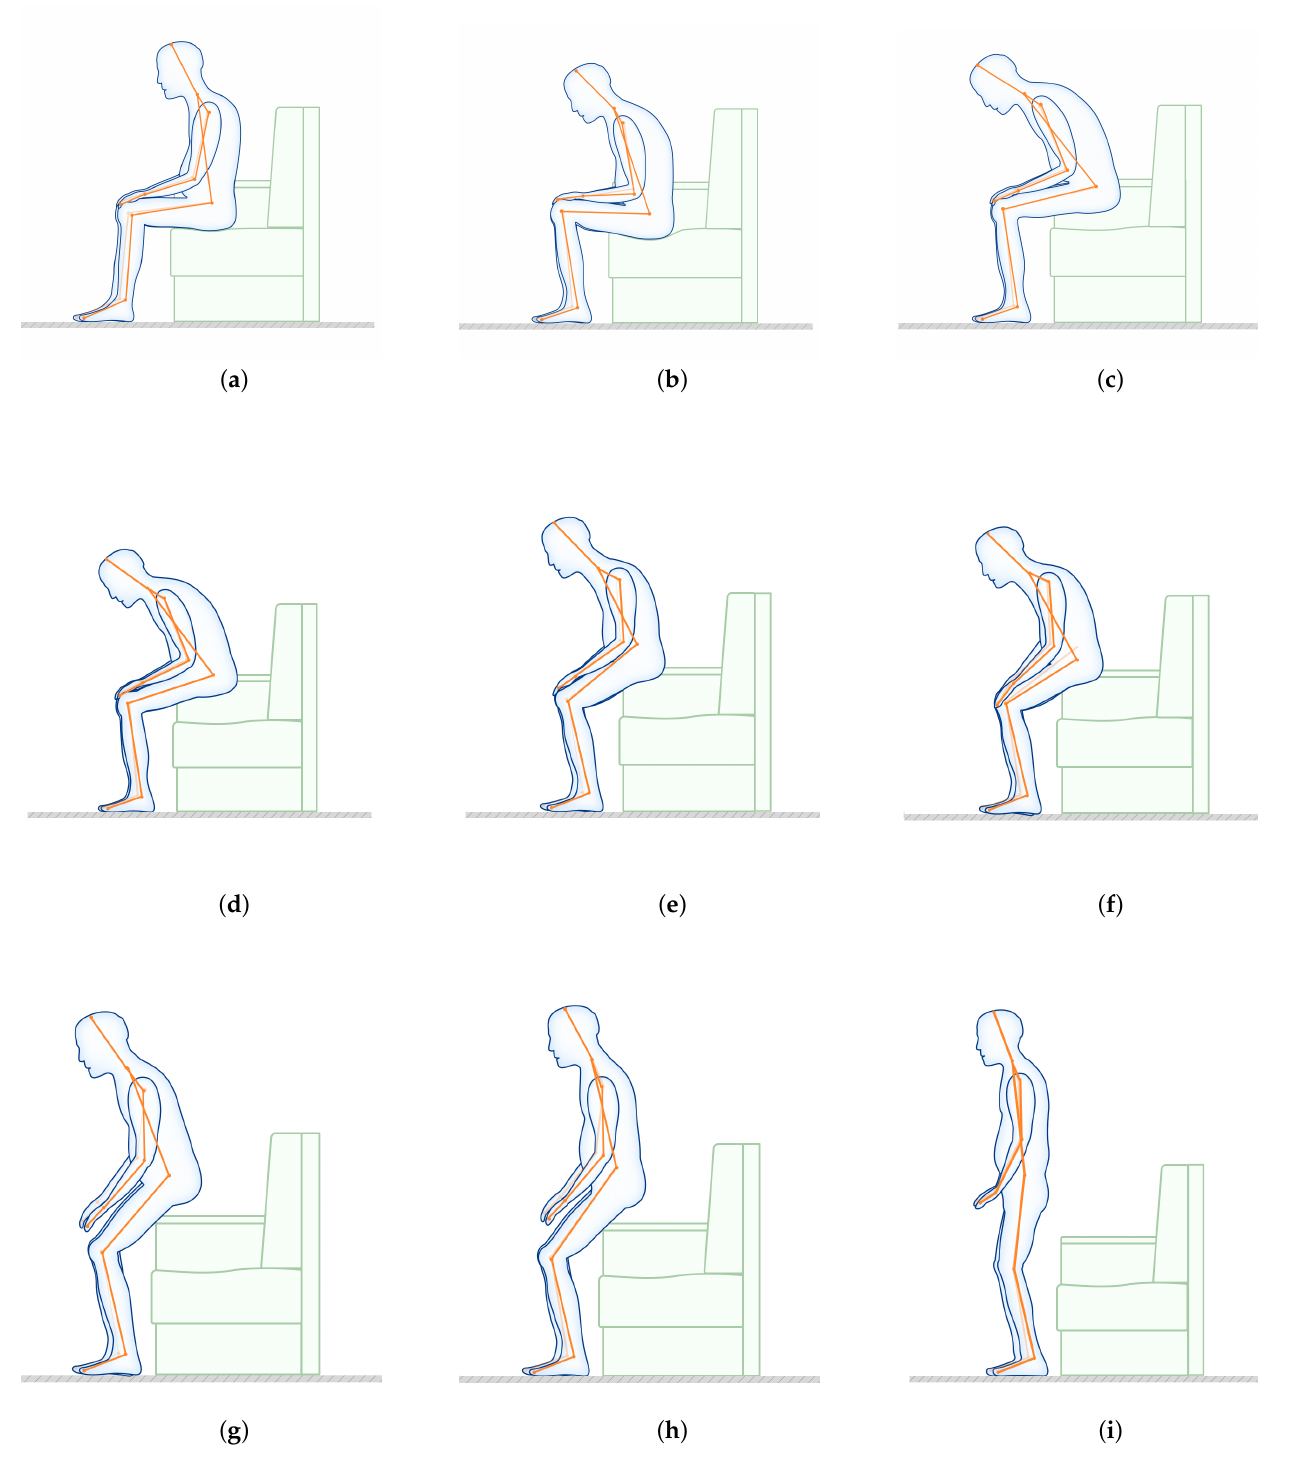
Figure 6. Sofa use behavior process. The whole process of subjects completing the experimental instructions was divided into nine stages, reflecting the whole process of subjects completing the sit-to-stand transition. ( a ) Clustering gesture one. ( b ) Clustering gesture two. ( c ) Clustering gesture three. ( d ) Clustering gesture four. ( e ) Clustering gesture five. ( f ) Clustering gesture six. ( g ) Clustering gesture seven. ( h ) Clustering gesture eight. ( i ) Clustering gesture